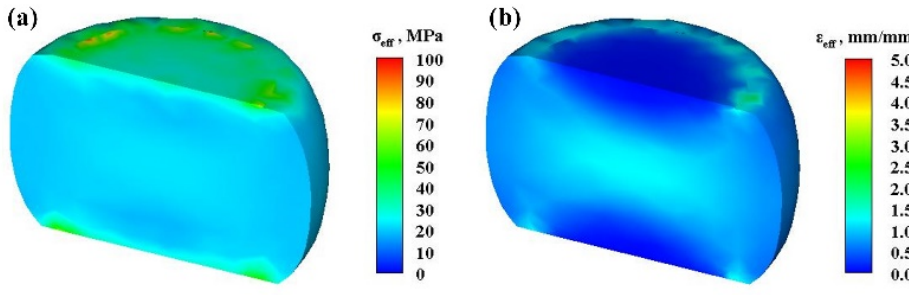
Figure 10. ( a ) Effective stress and ( b ) strain distributions of specimens after upsetting.